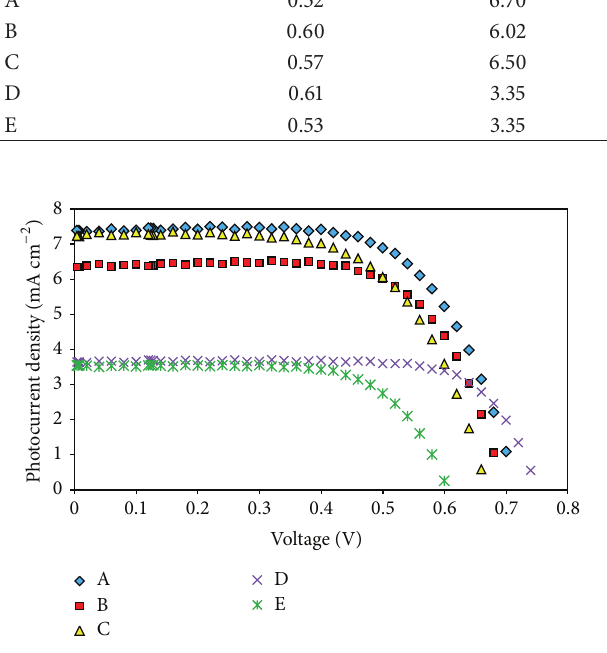
Figure 8: Photocurrent-voltage curves of DSSCs with phthaloylchi- tosan with based electrolyte different ratio of LiI:Pr 4 NI binary salt.